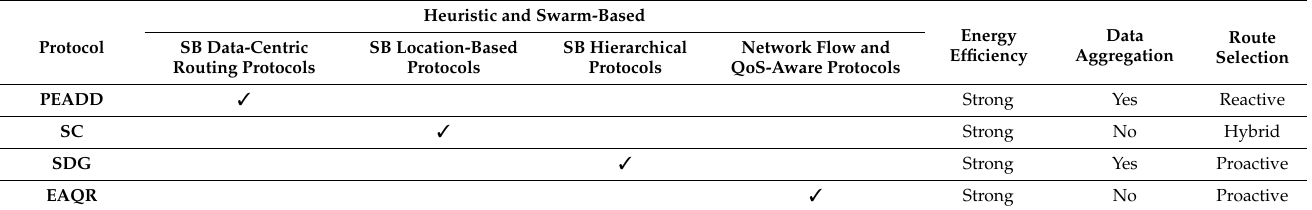
Table 10 establishes a comparison between heuristic and swarm-based routing proto- cols [120]. Table 10. Comparison between heuristic and swarm-based routing protocols for WSNs. Protocol